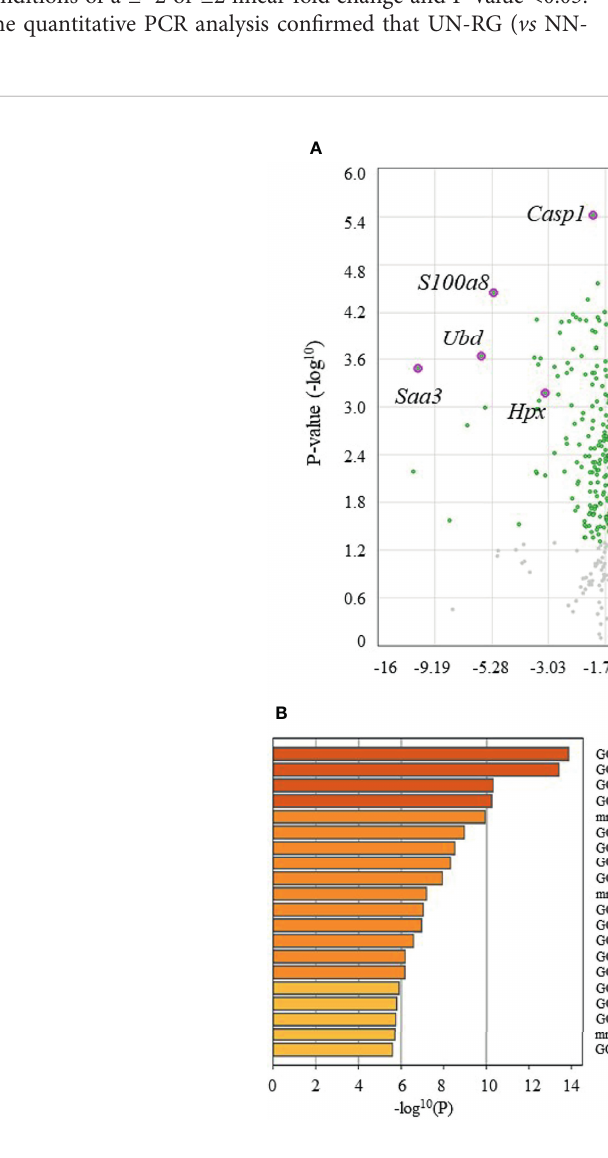
FIGURE 5 | Volcano plots (A) and GO terms from a gene enrichment analysis (B) using microarray data from epididymal adipose tissues of UN-RG-TU and UN-RG- Veh pups (4 each) at 16.5 wks. The names of 7 GOI ( Table 3 ) were plotted in volcano plots (A)